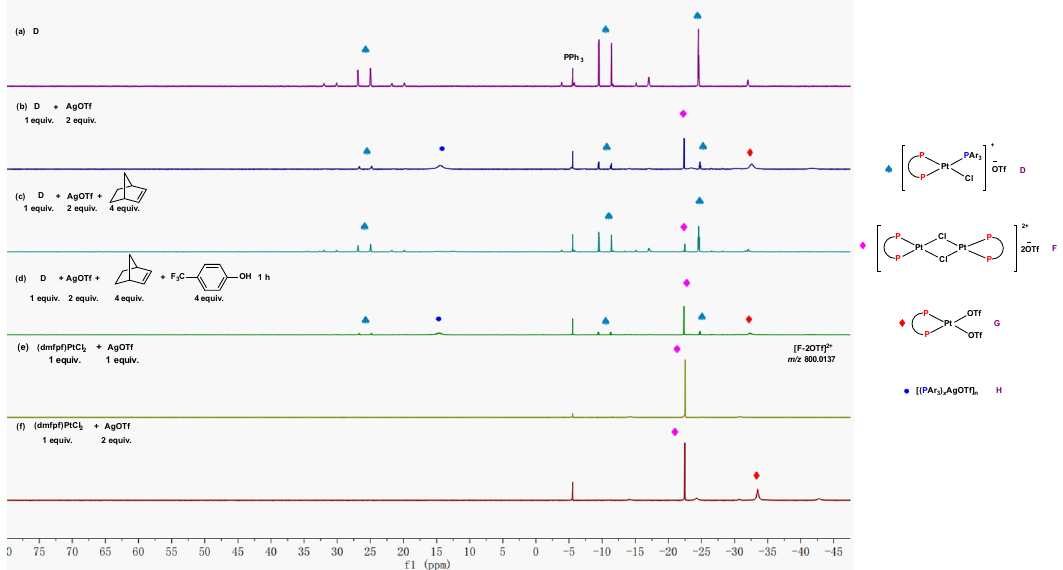
Fig. 8 31 P NMR spectra for monitoring the reaction of catalyst D + AgOTf + norbornene + 4-tri fl uromethylphenol (PPh 3 was used as an external standard). a 31 P NMR spectra of complex D. b 31 P NMR spectra of a mixture of complex D (1 equiv.) and AgOTf (2 equiv.). c 31 P NMR spectra of a mixture of complex D (1 equiv.), AgOTf (2 equiv.), and norbornene (4 equiv.). d 31 P NMR spectra of a mixture of complex D (1 equiv.), AgOTf (2 equiv.), norbornene (4 equiv.), and 4-tri fl uoromethylphenol (4 equiv.). e 31 P NMR spectra of a mixture of (dmfpf)PtCl 2 (1 equiv.), and AgOTf (1 equiv.). f 31 P NMR spectra of a mixture of (dmfpf)PtCl 2 (1 equiv.), and AgOTf (2 equiv.). Speci fi cally, (dmfpf)PtCl 2 :1.1 ′ -[bis(5-methyl-2-furanyl)phosphine]ferrocene platinum dichloride; AgOTf: silver tri fl